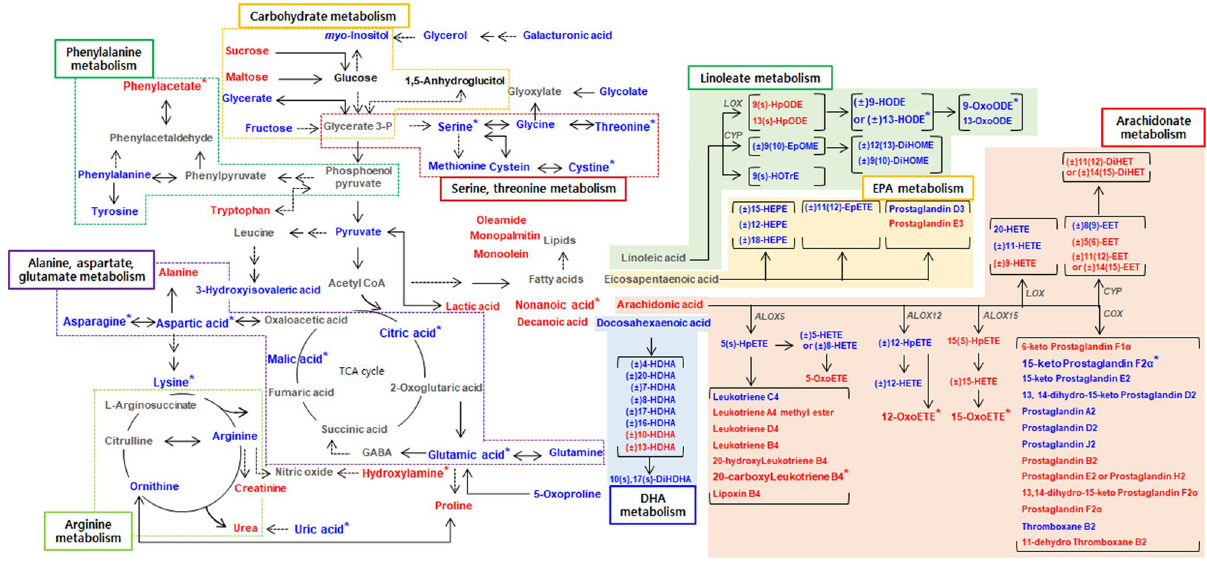
Figure 4. Schematic diagram of a proposed metabolic pathway using plasma metabolites derived from metabolite and lipid profiling of experimental groups including diabetic macular edema (DME) and non-DME subjects. Metabolites labelled with blue characters indicate that relative metabolite levels were lower in DME cases than in non-DME subjects. Metabolites labelled with red character s indicate that relative metabolite levels were higher in DME cases than in non-DME patients. Asterisks indicate statistically significant differences in levels of metabolites distinguishing DME and non-DME individuals ( p < 0.05). The metabolic pathway was modified from the reported Kyoto Encyclopedia of Genes and Genomes pathway (KEGG, http:// www. genome. jp/